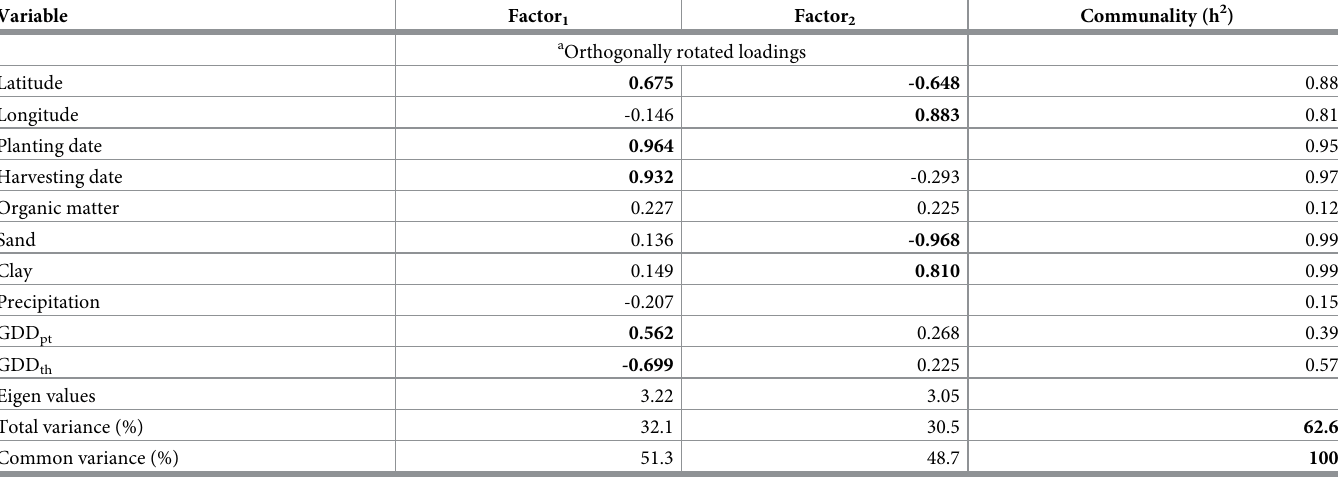
Table 4. Exploratory factor analysis results, based on varimax rotation, using the correlation matrix of environmental and crop management variables from thirty fields in which optimum plant density for processing sweet corn was quantified in field trials in Illinois, Minnesota, and Wisconsin from 2013 to 2017. Factor load- ings from variables that were greater than 0.400 in magnitude are in bold.